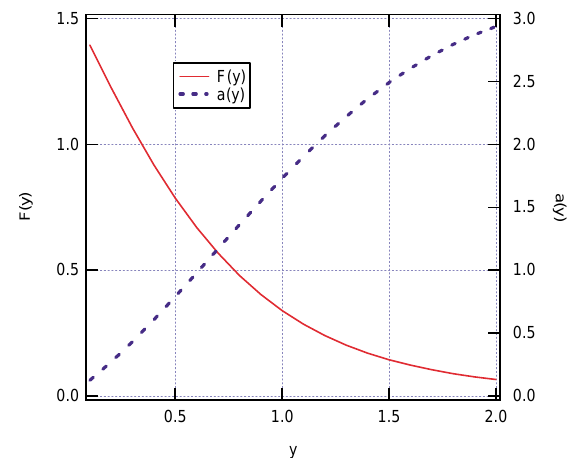
FIG. 1. (Color) Normalized convolution F (cid:2) y (cid:3) between bunch spectrum and beam power spectrum vs bunch length times reso- nant frequency and the exponent a of the power law fit for the loss dependence on bunch length U pm ~ (cid:2) s (cid:1) s 0 (cid:3) a . In Fig. 1 the normalized convolution integral F (cid:2) y (cid:3) and the exponent a are plotted as a function of y (cid:1) v r s t .